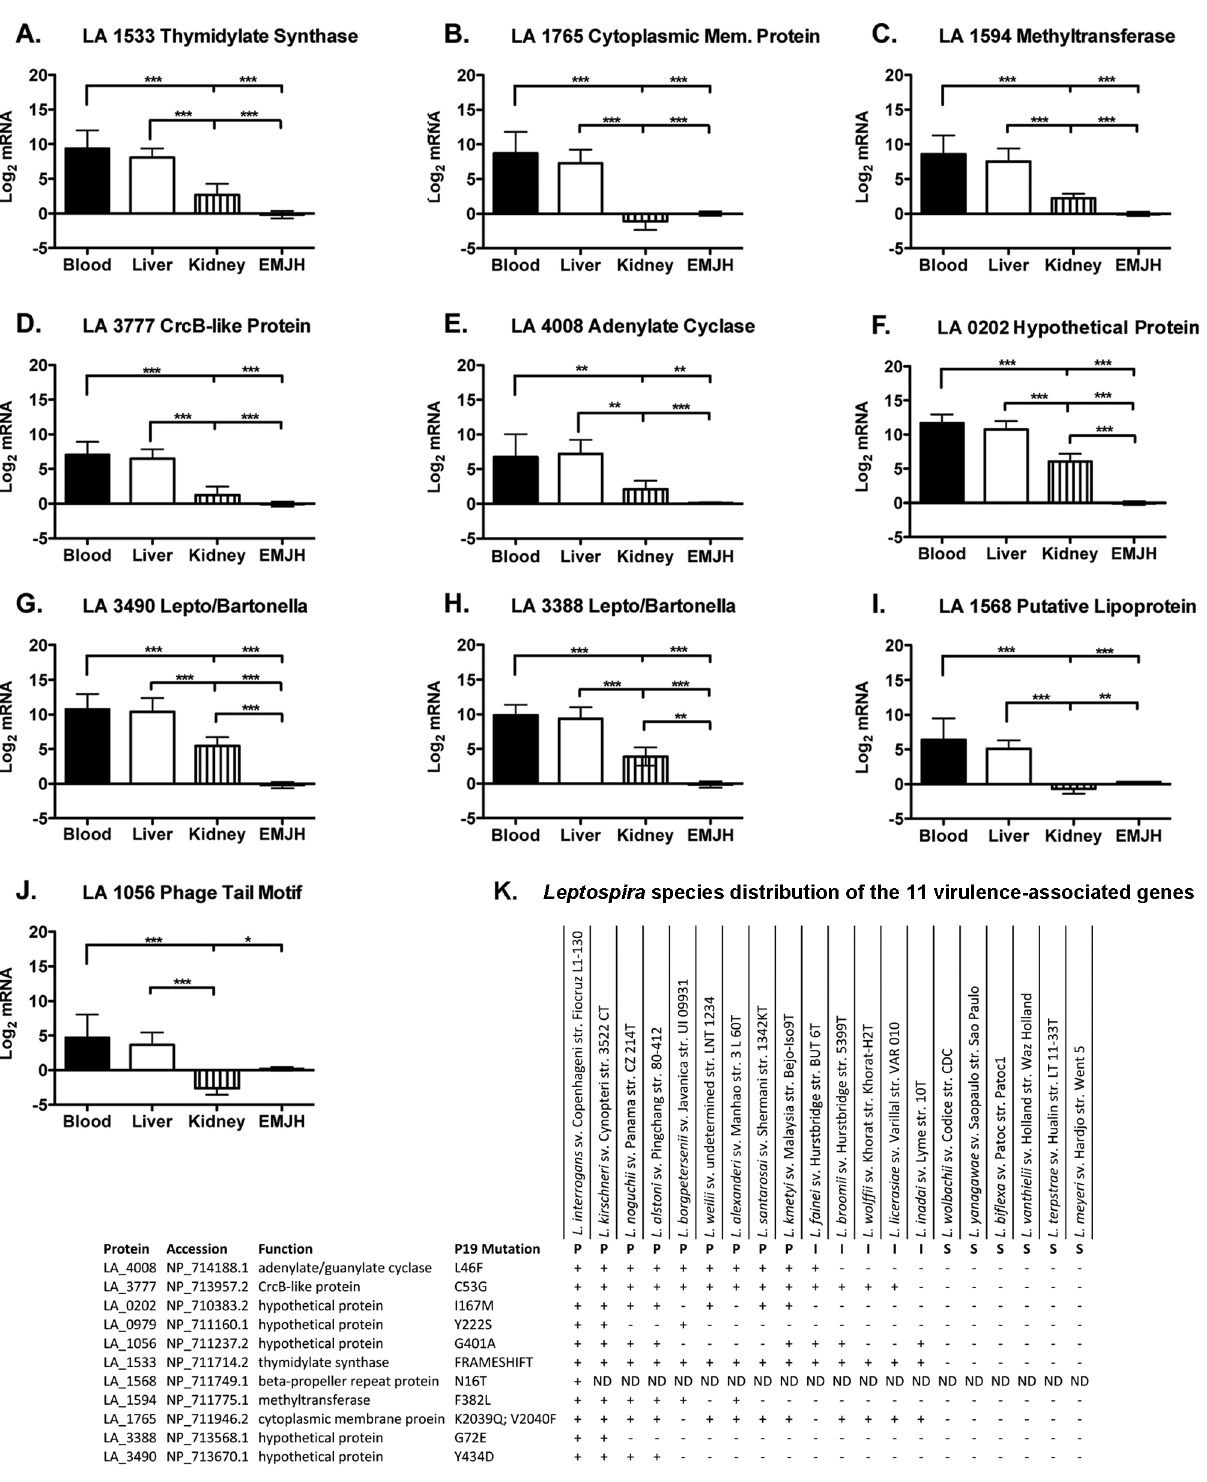
Figure 2. Invivo transcriptional analysis of putative virulence-associated genes. In vivo relevance of the identified virulence-related genes, mRNA transcript levels of the genes identified by the pathogenomics approach was assessed by real time, reverse transcriptase quantitative PCR of blood, liver and kidney 4 d after hamster infection, compared to log phase in vitro cultured Leptospira . Leptospiral gene expression levels in infected tissue vs. EMJH were expressed logarithmically as the log 2 of the fold change between the two conditions ( A–J ). 16S rRNA transcript levels (previously validated [61]) were used to normalize gene expression in tissues and under the different conditions (Fig. S1 in Text S1). Expression of 10/ 11 identified genes was detectable in vivo in all three tissues assayed; the exception was the hypothetical protein LA_0979. The remaining 10 genes were detected in all three tissues assayed. Expression varied between groups of animals, and interestingly, the highest levels of up-regulation were found in leptospires isolated from the blood of infected animals, with transcript levels also being up in bacteria from the liver. Virulence-associated genes were variably up-regulated in kidney. The data represented are the mean 6 SEM of 3 independent experiments (n=7 animals). ( K ) Leptospira